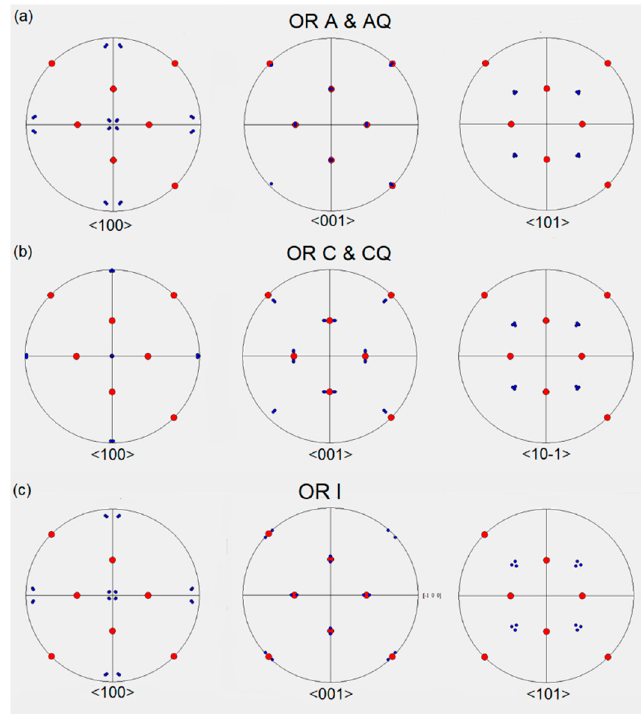
Figure 9. GenOVa simulations of the pole figures of all the B19 ′ variants with ( a ) OR A and OR AQ and with ( b ) OR C and OR CQ. ( c ) OR I. The equivalent B19 ′ directions are in blue. The <110> B2 directions are in red.